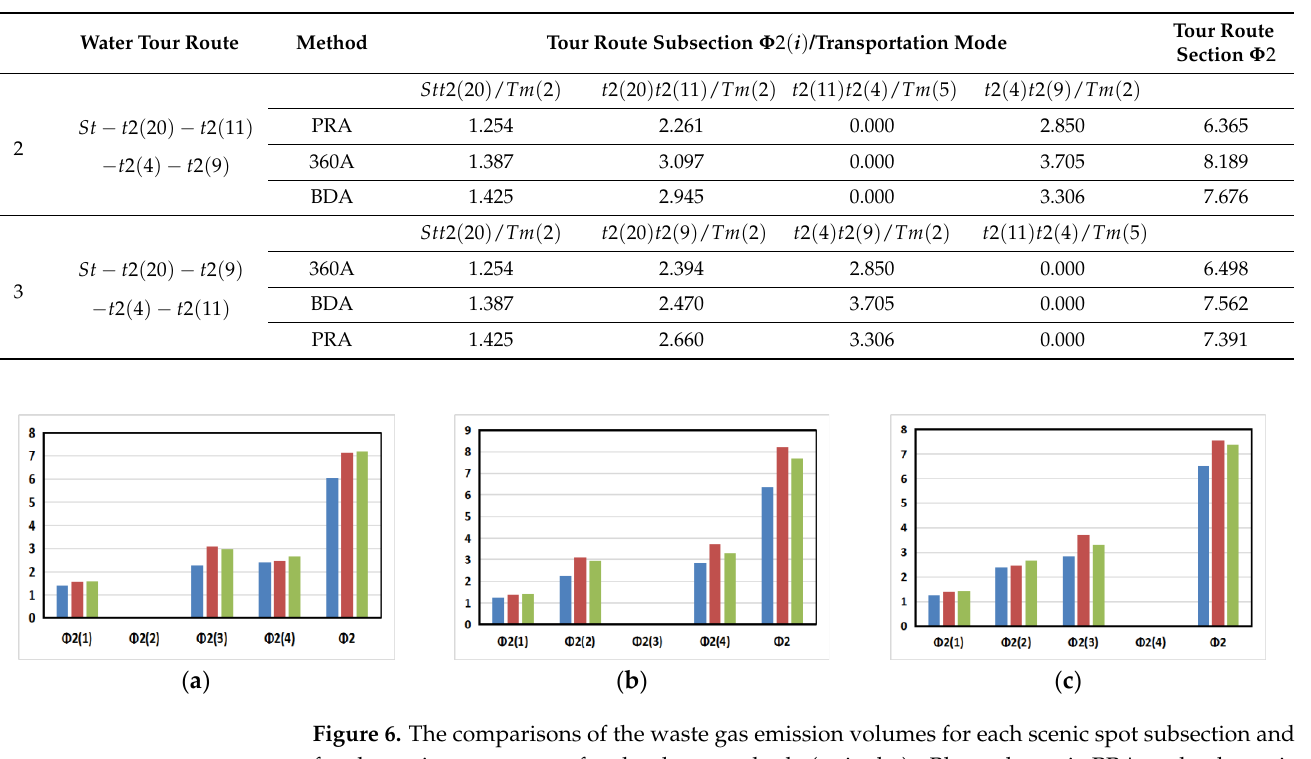
Figure 6. The comparisons of the waste gas emission volumes for each scenic spot subsection and for the entire tour routes for the three methods (unit: kg). Blue column is PRA, red column is 360A, green column is BDA. ( a – c ) are the comparison results for water tour route 1, route 2, and route 3, respectively.